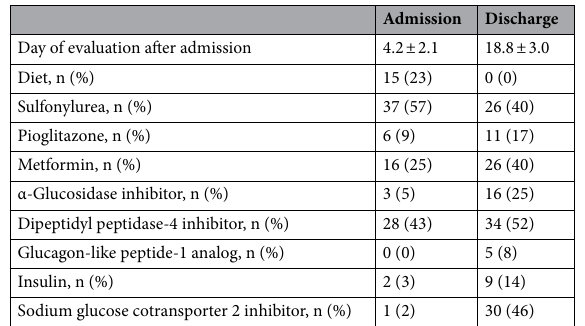
Table 2. Changes in glucose-lowering medications during hospitalization (n = 65). Data are n (%).